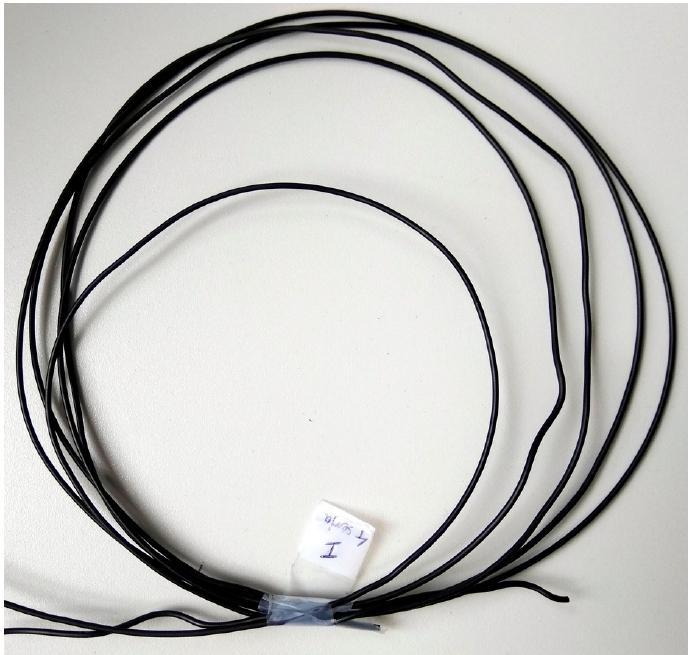
Figure 3. Extruded composite filaments filled with 9.09 wt.% of carbon nanotubes, with diameters in the range of 1.7–1.8 mm.